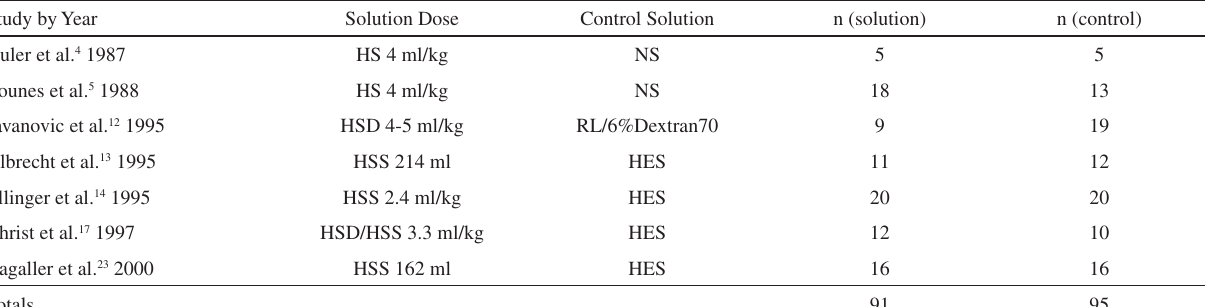
Table 2 - Perioperative studies on the use of hypertonic saline (7.2-7.5% NaCl) alone or in association with either dextran (HSD) or hydroxielthyl starch (HSS) compared to hydroxiethyl starch (HES), Ringer’s solution (RL)/6% Dextran70, or normal saline (NS) in aortic aneurysm